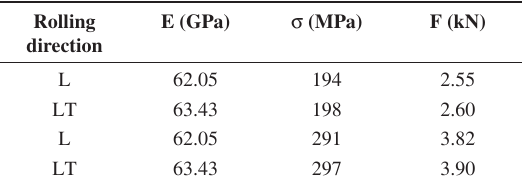
Figure 11. Coupons after CAF: a) coupons and gage, b) deflection measurement. Table 4. Force to push the coupon against the tool.